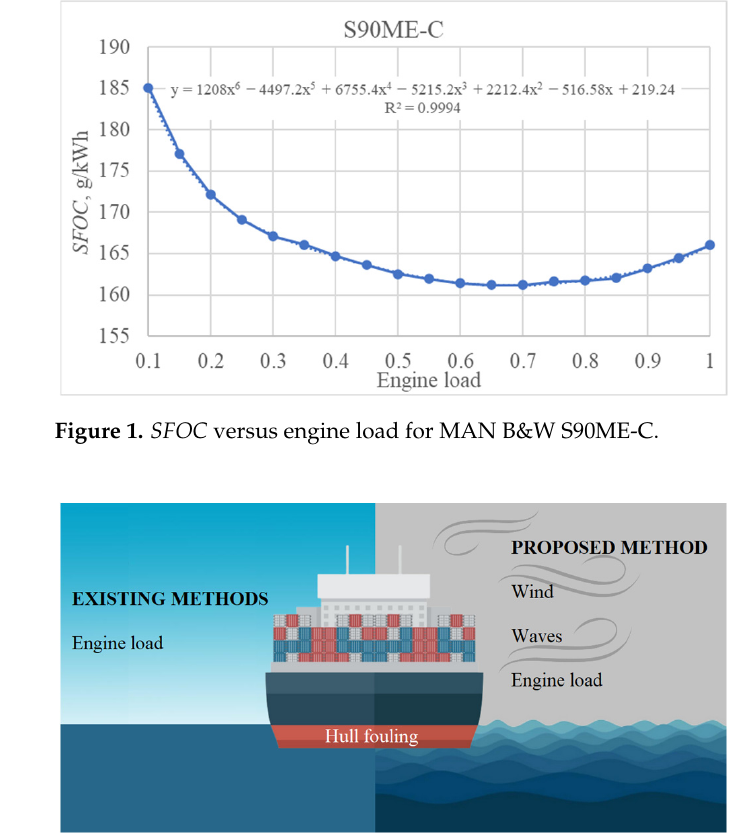
Figure 2. The comparison of the proposed method and other existing methods in the literature